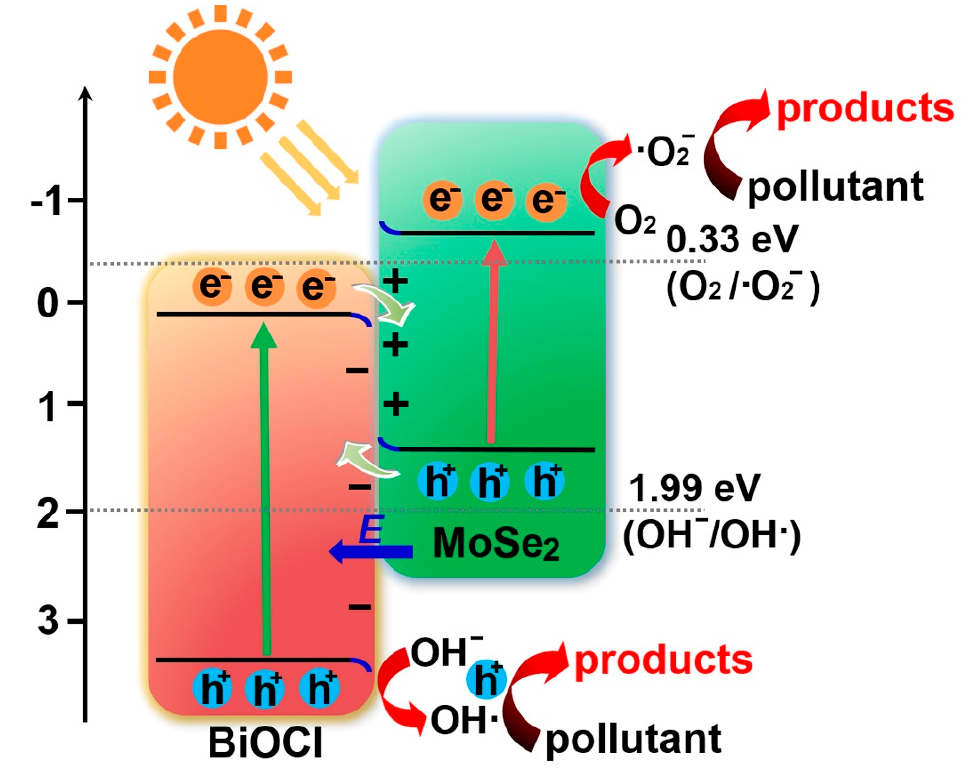
Figure 7. Proposed photocatalytic mechanism of S-scheme BiOCl/MoSe 2 .